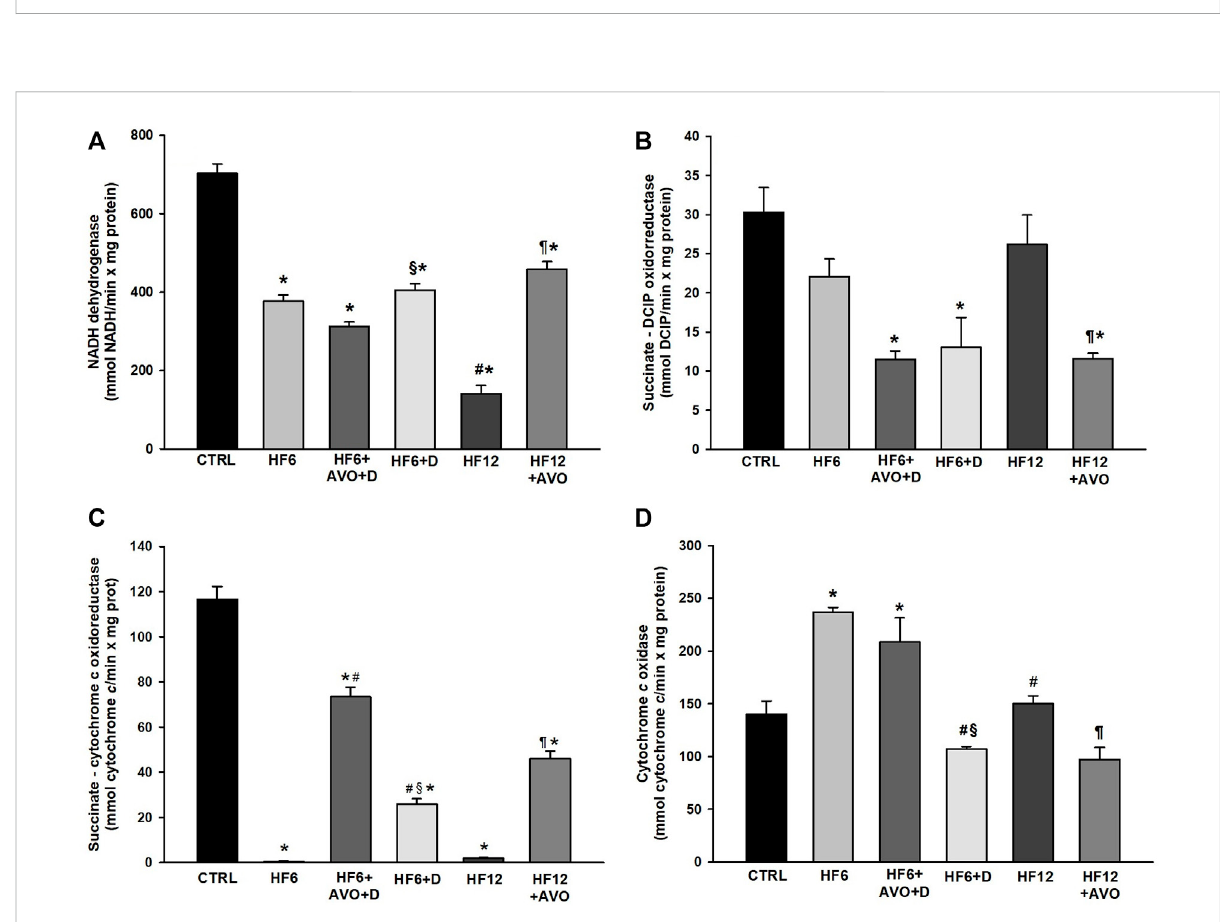
FIGURE 5 Effectsofavocadooil(AVO)on theactivitiesofthecomplexesI (A) ,II (B) , II-III (C) ,andIV (D) oflivermitochondria fromratsfedwithahighfat- highfructosediet(HF).Dataareexpressedasthemean±standarderrorofn ≥ 3.* p < 0.05vs.CTRL; # p < 0.05vs.HF6; § p < 0.05vs.HF6+AVO+D; p < 0.05 vs. HF12 (ANOVA, Holm- Š ídák ’ s post hoc